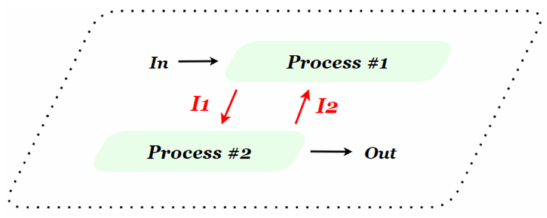
Figure 9. The Tactical plane focuses on main process interactions.